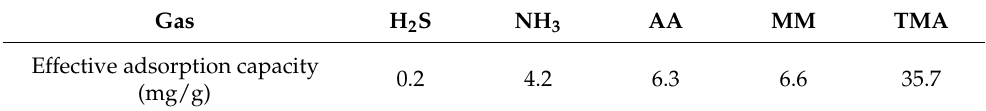
Figure 3. Breakthrough curve of exhaust gases on activated carbon. Total flow rate is 1 L/min and initial feed concentration is 100 ppm. The feeding gases were hydrogen sulfide (H 2 S), ammonia (NH 3 ), acetaldehyde (AA), methyl mercaptan (MM), and trimethylamine (TMA). Table 2. Effective adsorption capacity (<1 ppm) of activated carbon toward five different